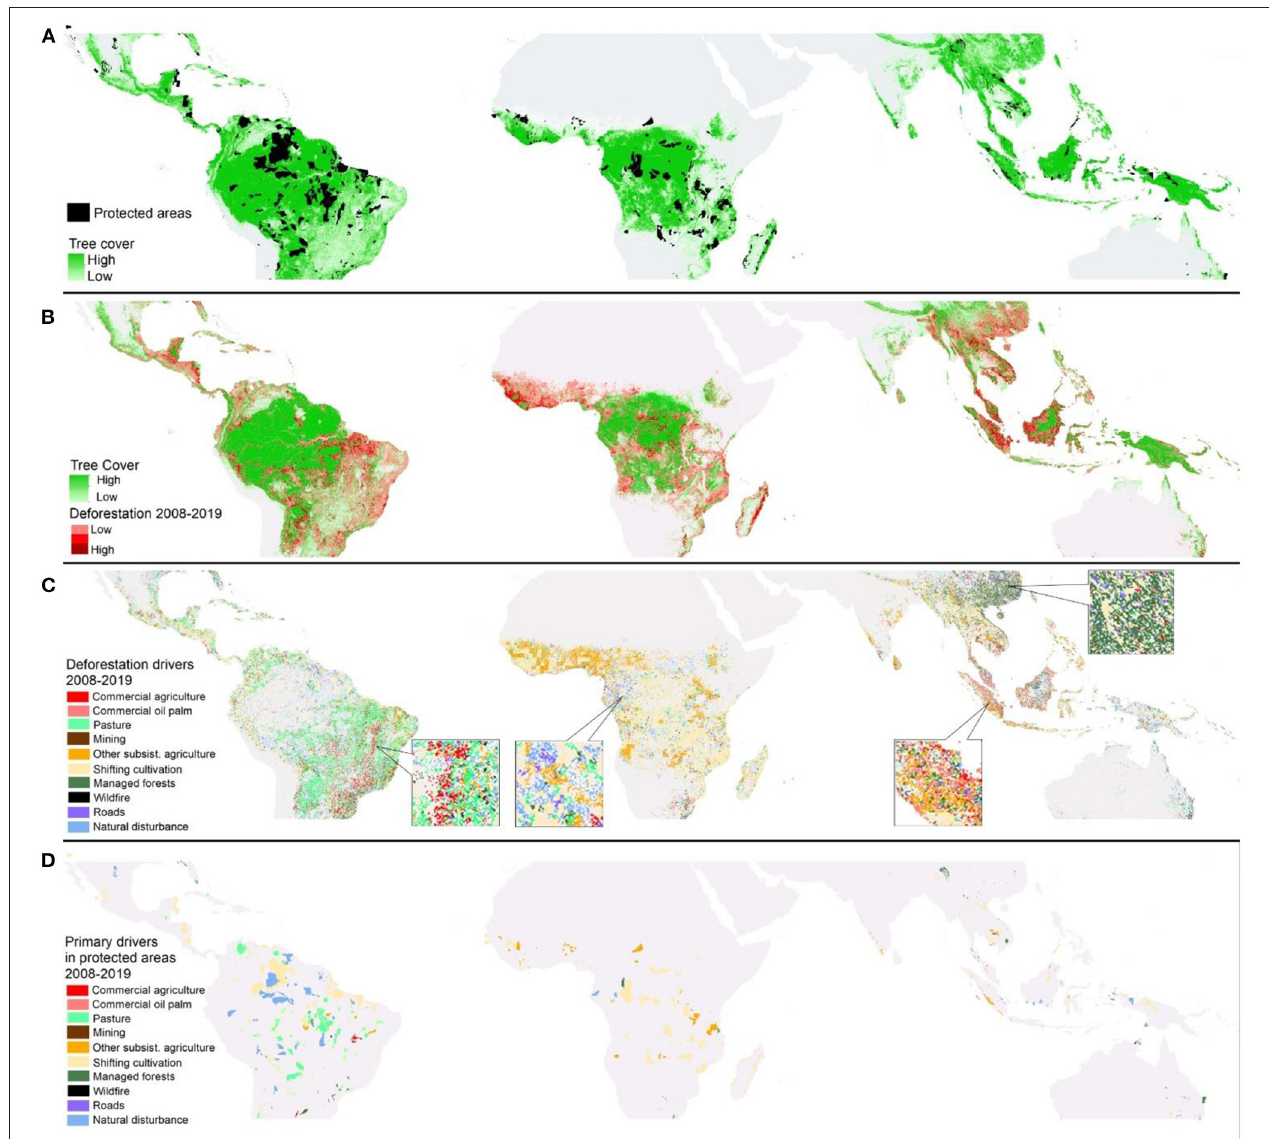
FIGURE 2 | (A) Protected areas and percentage tree cover in 2000; (B) Deforestation between 2008 and 2019 and tree cover in 2000; (C) The primary drivers of deforestation (2008–2019) in tropical areas; and (D) in protected areas with forest cover > 10,000 ha. Source: World Database of Protected Areas; Global Forest Change data sets (Laso Bayas et al.,